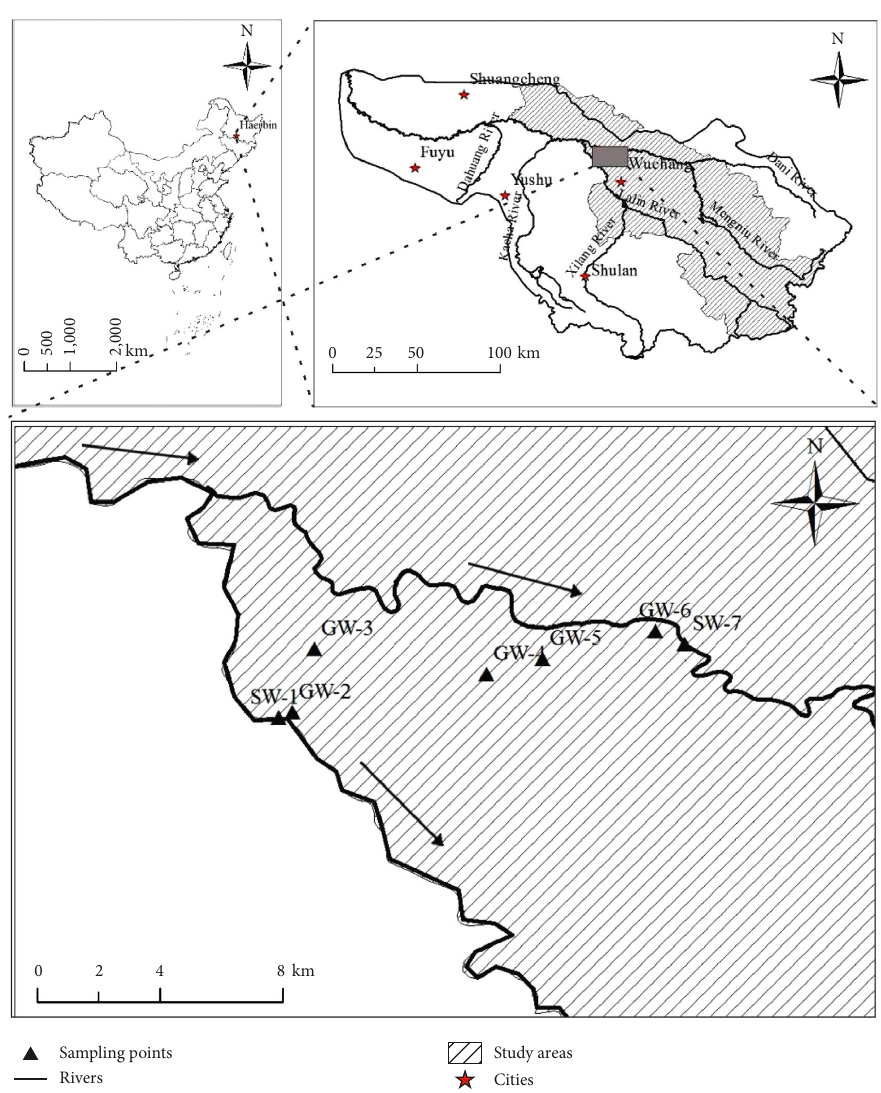
Figure 1: Sampling locations in Wuchang City,